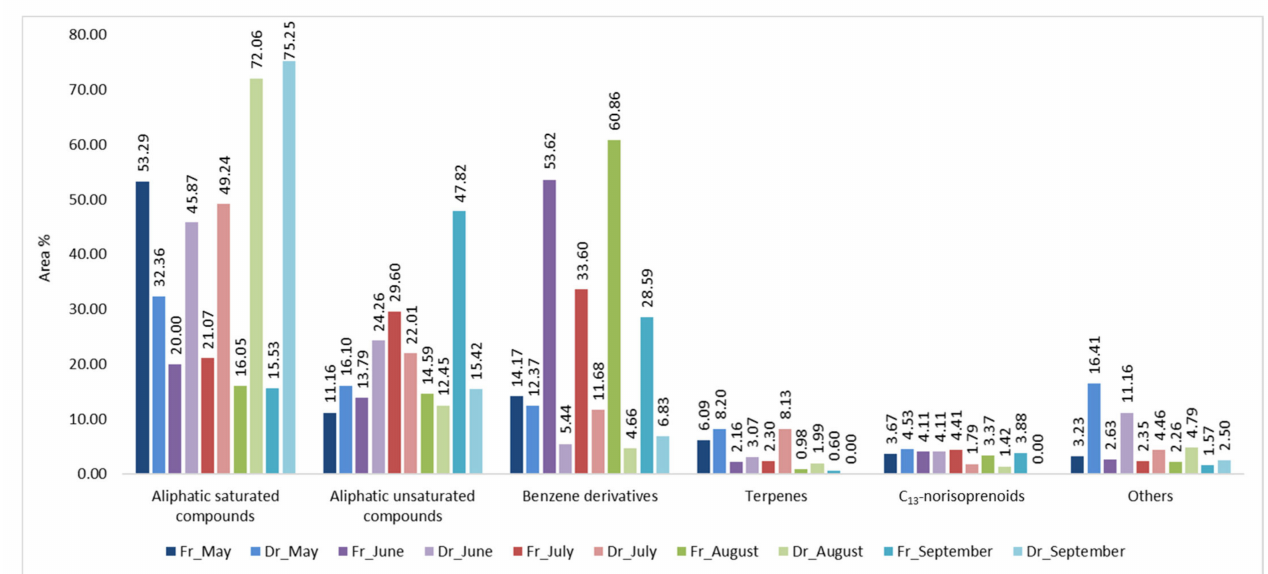
Figure 2. Total ion chromatogram (TIC) comparison of H. scoparia isolated by headspace solid-phase microextraction (HS-SPME) and analysed by gas chromatography–mass spectrometry (GC–MS) using DVB/CAR/PDMS fibre (f1): ( a ) in May; ( b ) in September.